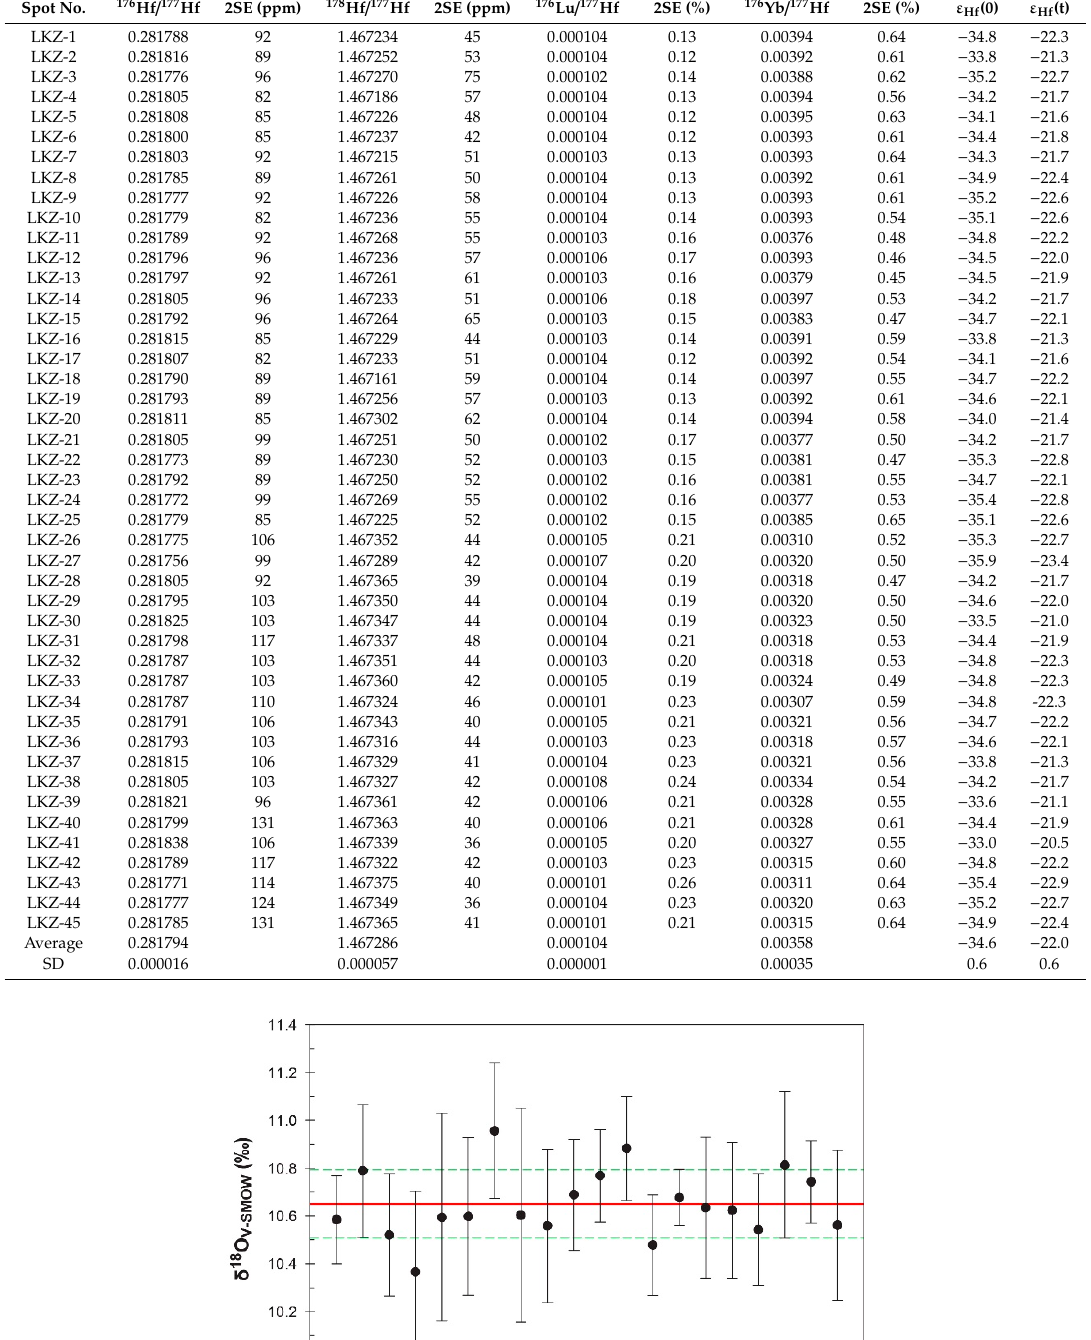
Table 6. LA-MC-ICPMS Lu–Yb–Hf results for the LKZ-1 zircon. Spot No.